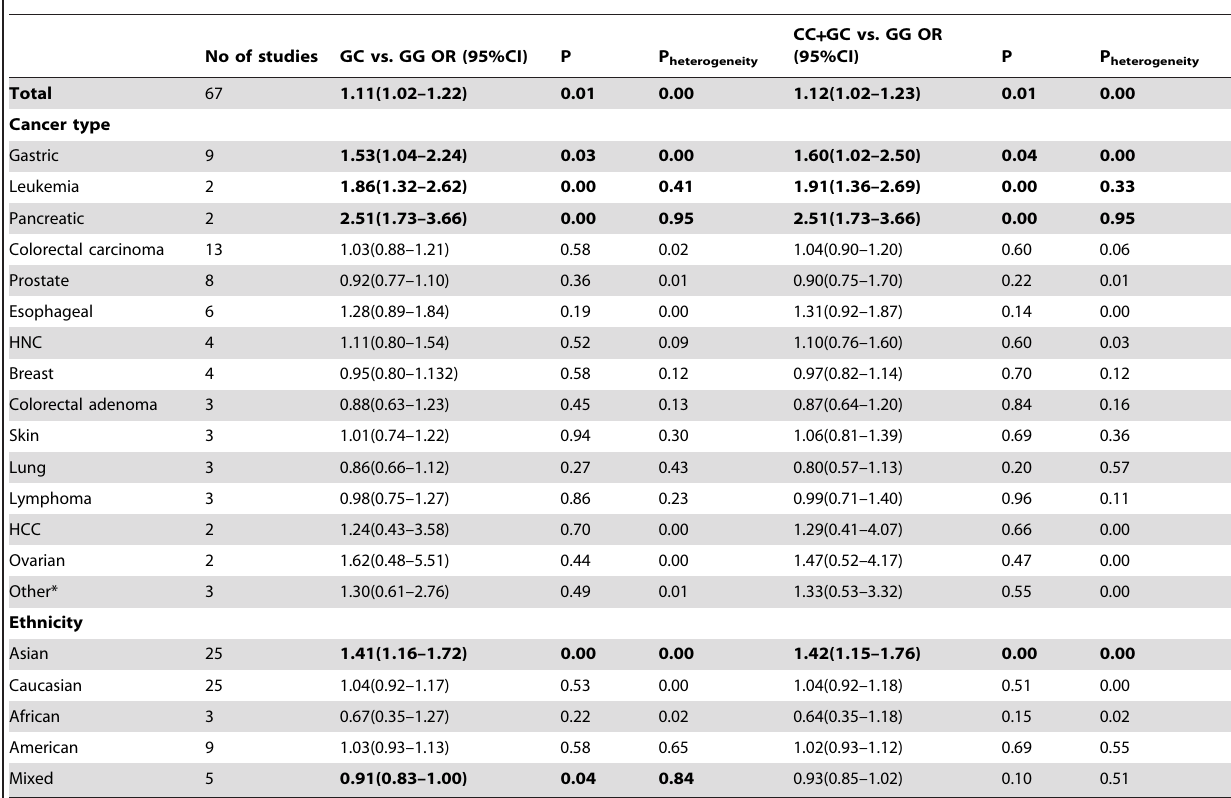
Table 2. Quantitive synthesis of the associations between COX-2-765 G . C polymorphism and cancer risk in two models.